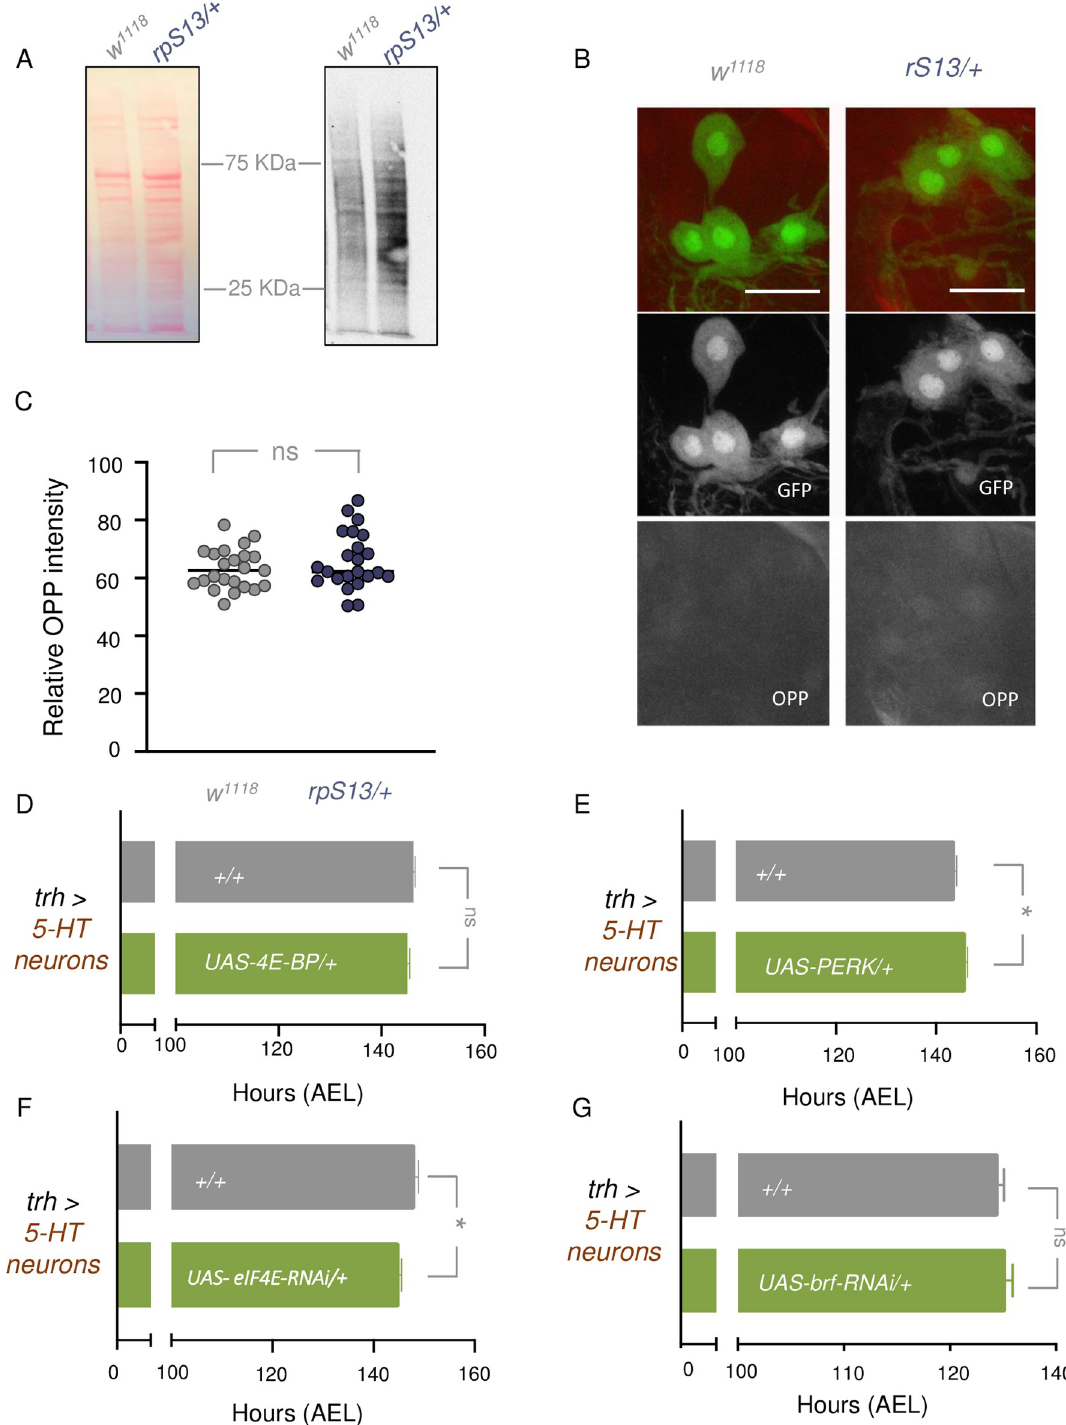
Fig 5. Inhibiting translation in 5-HT neurons does not recapitulate a Minute phenotype. (A) Puromycin labelling of w 1118 and rpsS13/+ third instar wandering larvae brains. Left, Ponceau S staining showing total protein. Right, anti-puromycin immunoblot. (B) OPP incorporation in 5-HT neurons, marked by GFP, from wandering L3 larvae. Scale bars, 10 μ m. (C) Quantification of OPP intensity in GFP marked 5-HT cells. +/+ n = 23, rpS13/+ n = 23. Individual data points are plotted, and the bars represent mean +/- SEM. ns = not significant, Student’s t-test. (D) Time to pupation of control larvae and larvae with UAS- 4E-BP overexpression in 5-HT neurons using trh-gal4 . +/+ n = 212, +/ UAS-4E-BP n = 141. Data are presented as +/- SEM. ns = not significant, Mann-Whitney